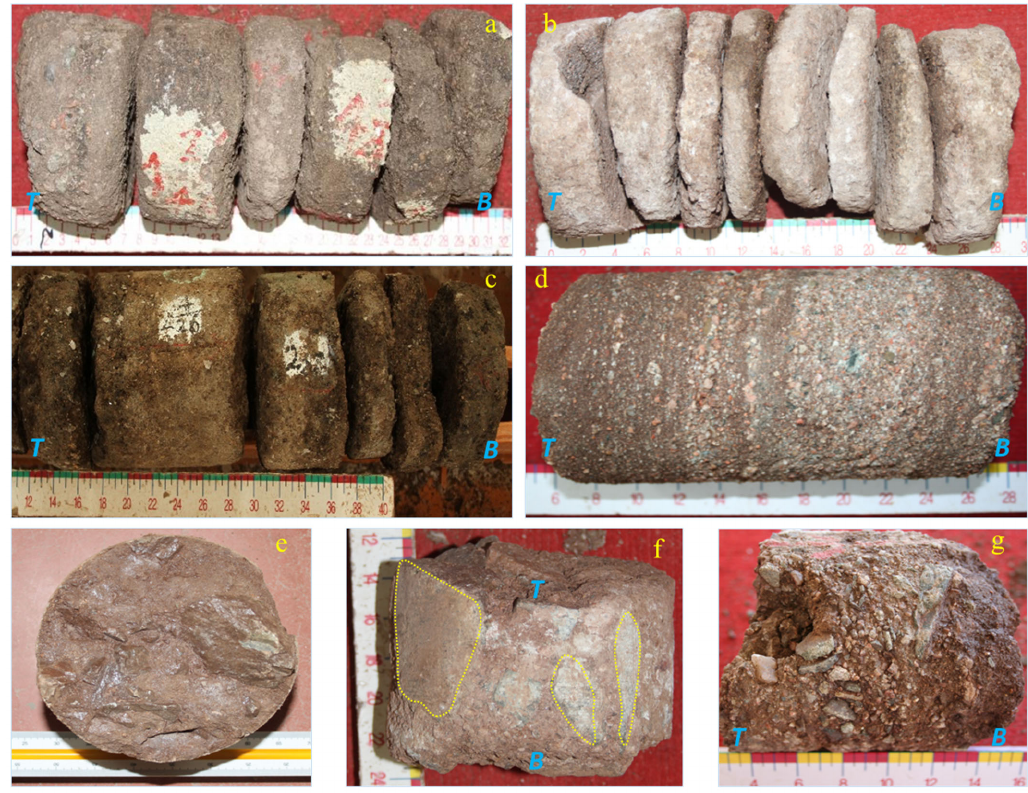
Figure 2. Typical sedimentary structures charts found in the Qie12 block: ( a ) Q12 − 10 − 8, 2059.1 m, tabular crossbedding; ( b ) Q12 − 7 − 28, 1829.4 m, tabular crossbedding; ( c ) Q12p1, 1809 m, tabular crossbedding; ( d ) Q125, 2026.5 m, trough crossbedding, gravel orientation arrangement; ( e ) Q12 − 23 − 6, 1917 m, massive bedding, gravel upright; ( f ) Q12 − 7 − 28, 1842.4 m, massive bedding, gravel upright; and ( g ) Q121, 1842.7 m, massive bedding. T is the top surface, and B is the bottom surface of the core in these figures.